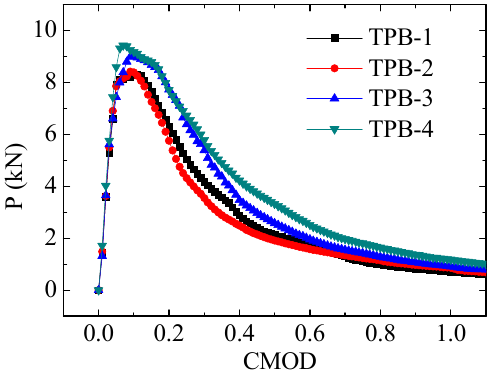
Figure 2. Load force - crack mouth opening displacement ( P -CMOD) curves of stand TPB tests.